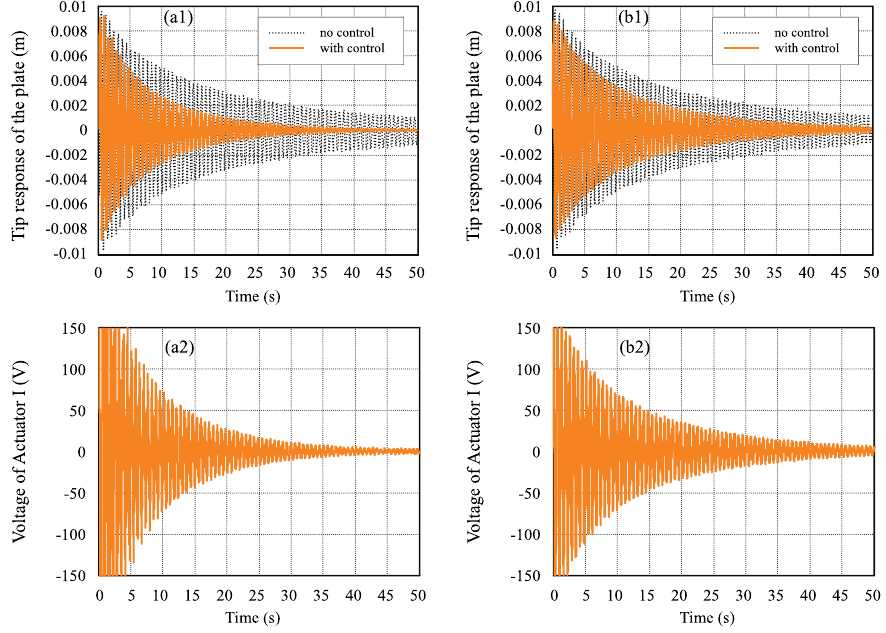
Fig. 9. Response of the plate and applied voltage of Actuator I when K = [1 . 4542 , 35 . 0246] and K (cid:4) = [ − 49 . 2654 , 62 . 1756] are used for the plate with time delay τ = 0 . 06s , respectively (one actuator case). (a) experimental result ( K (cid:4) = [ − 49 . 2654 , 62 . 1756] ); (b) experimental result ( K = [1 . 4542 , 35 . 0246] ).